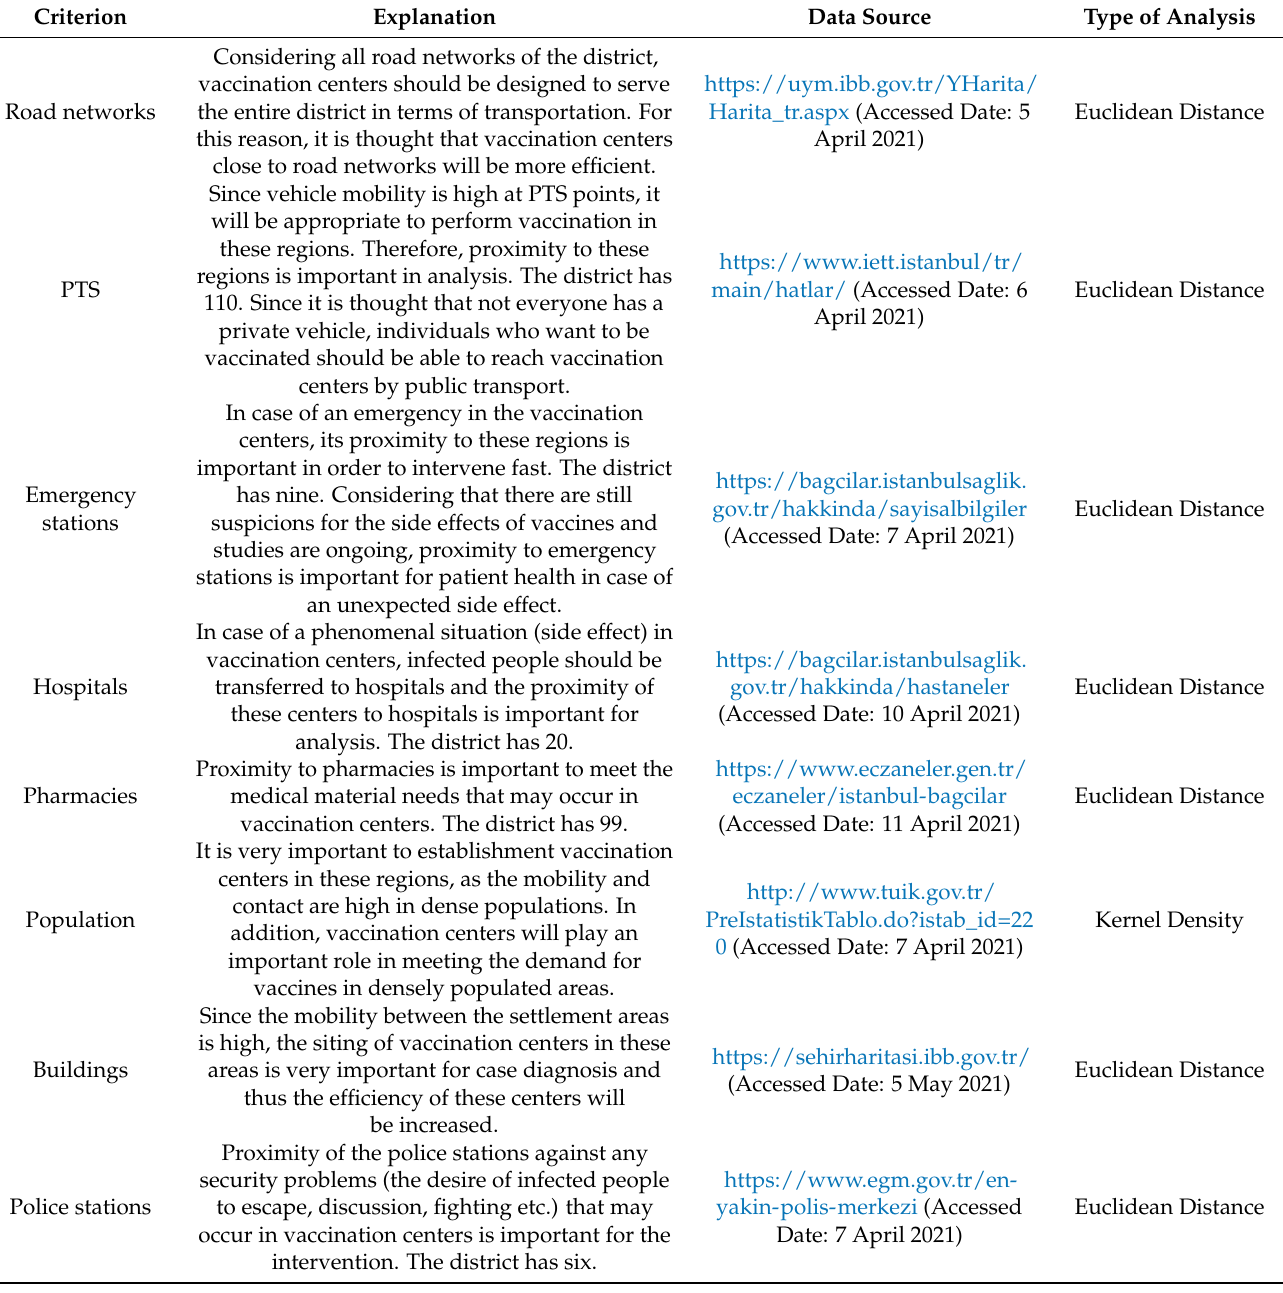
Table 2. Explanation and data source of evaluation